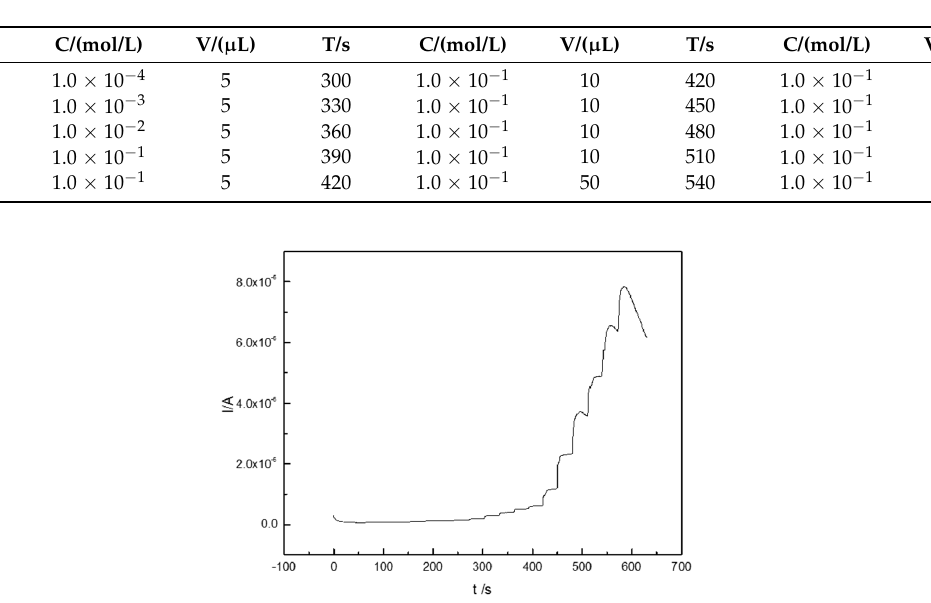
Table 1. The volume and concentration of H 2 O 2 used in test of the sensitivity of the CTS-CAT/ β -CD-FE composite electrode.